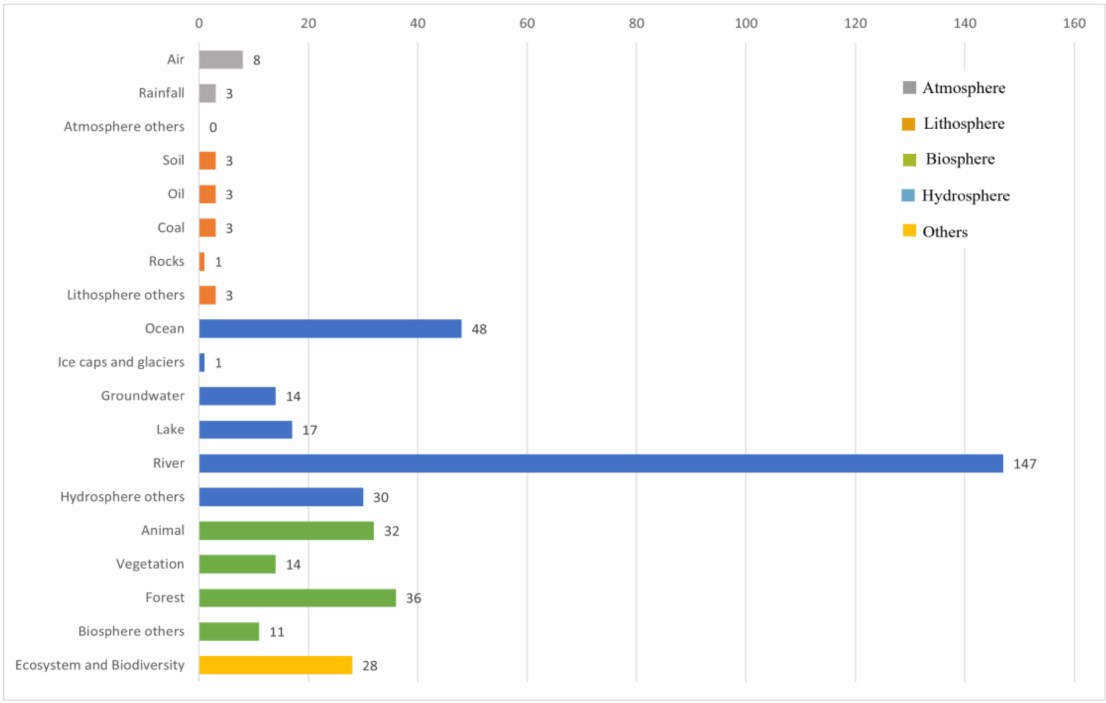
Figure 5. Number of the studies by natural